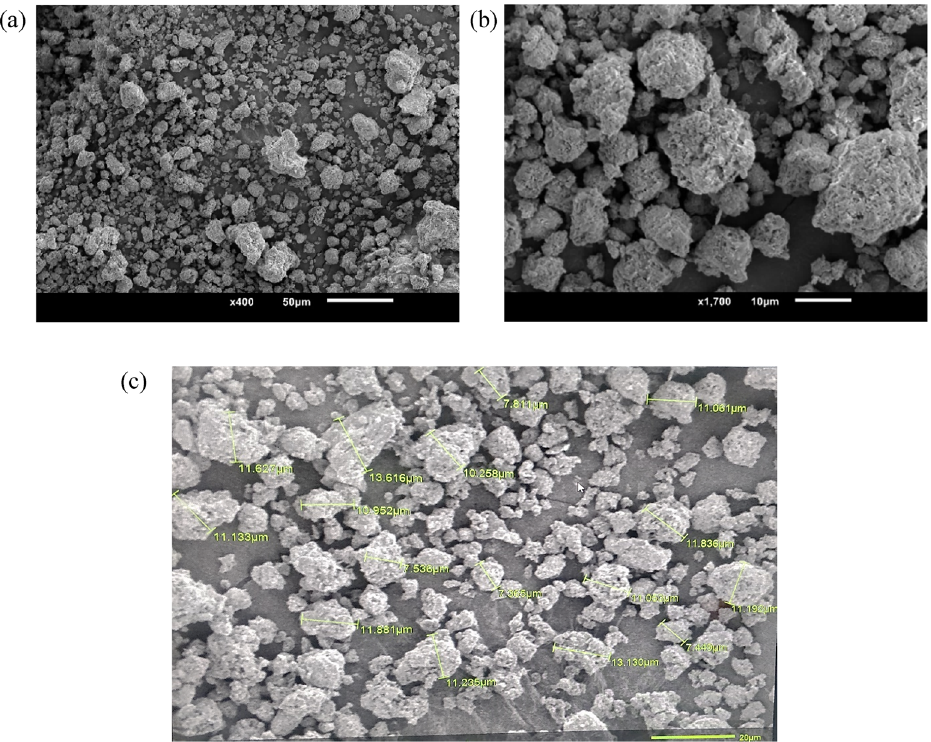
Figure 1: SEM observations of h - BN microparticles: ( a ) at × 400 magni fi cations, ( b ) at × 1,700 magni fi cations, and ( c ) size